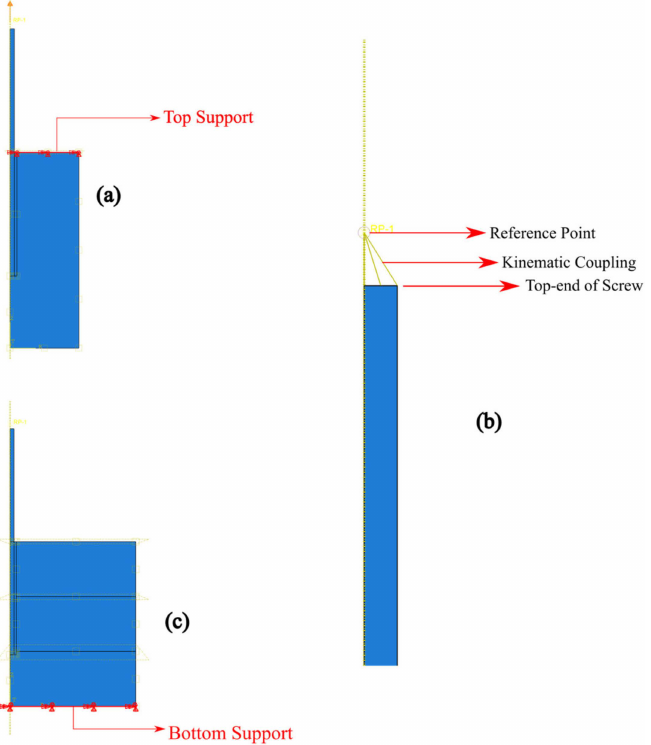
Figure 15. ( a ) Top boundary condition, ( b ) reference point at the screw top, and ( c ) bottom boundary condition. Table 22. Finite element verification